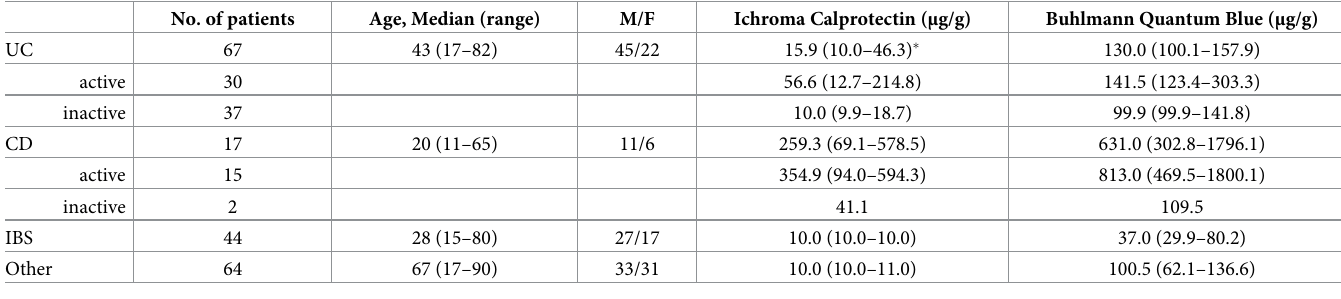
Table 2. Demographics and FC results of the study